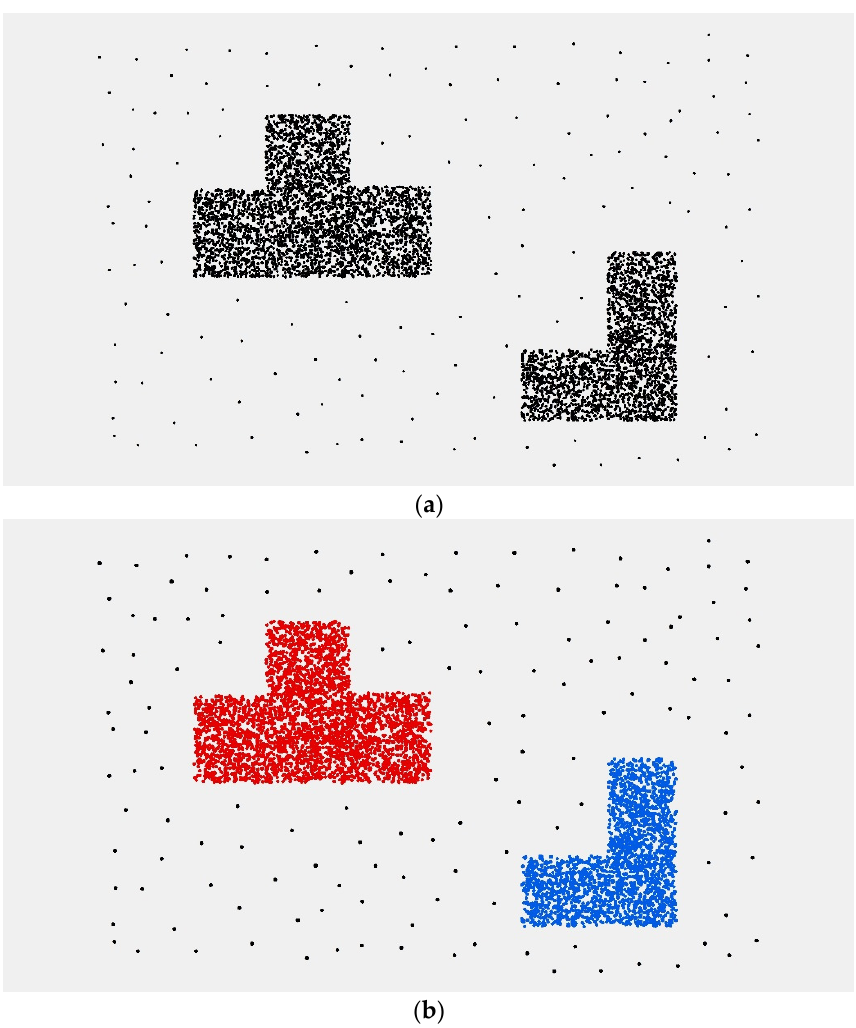
Figure 3. Experimental results. ( a ) Experimental data. ( b ) Clustering result using the CDHC algorithm.